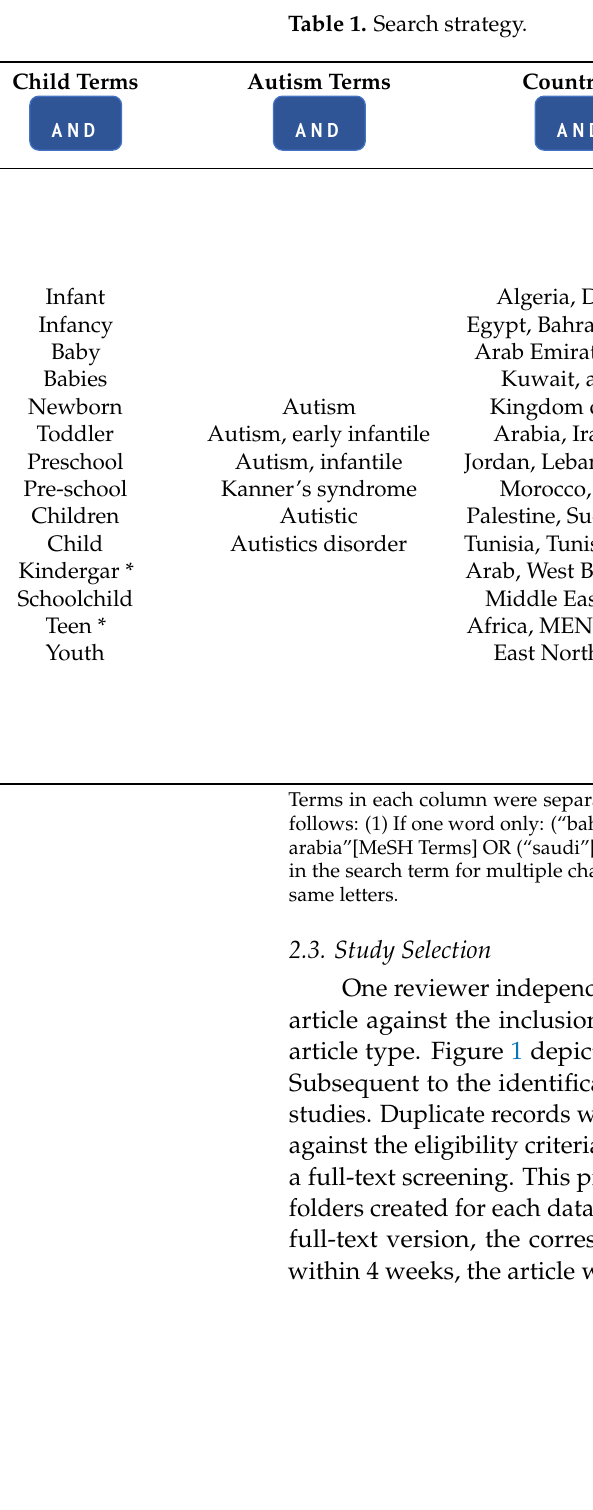
Table 1. Search strategy.